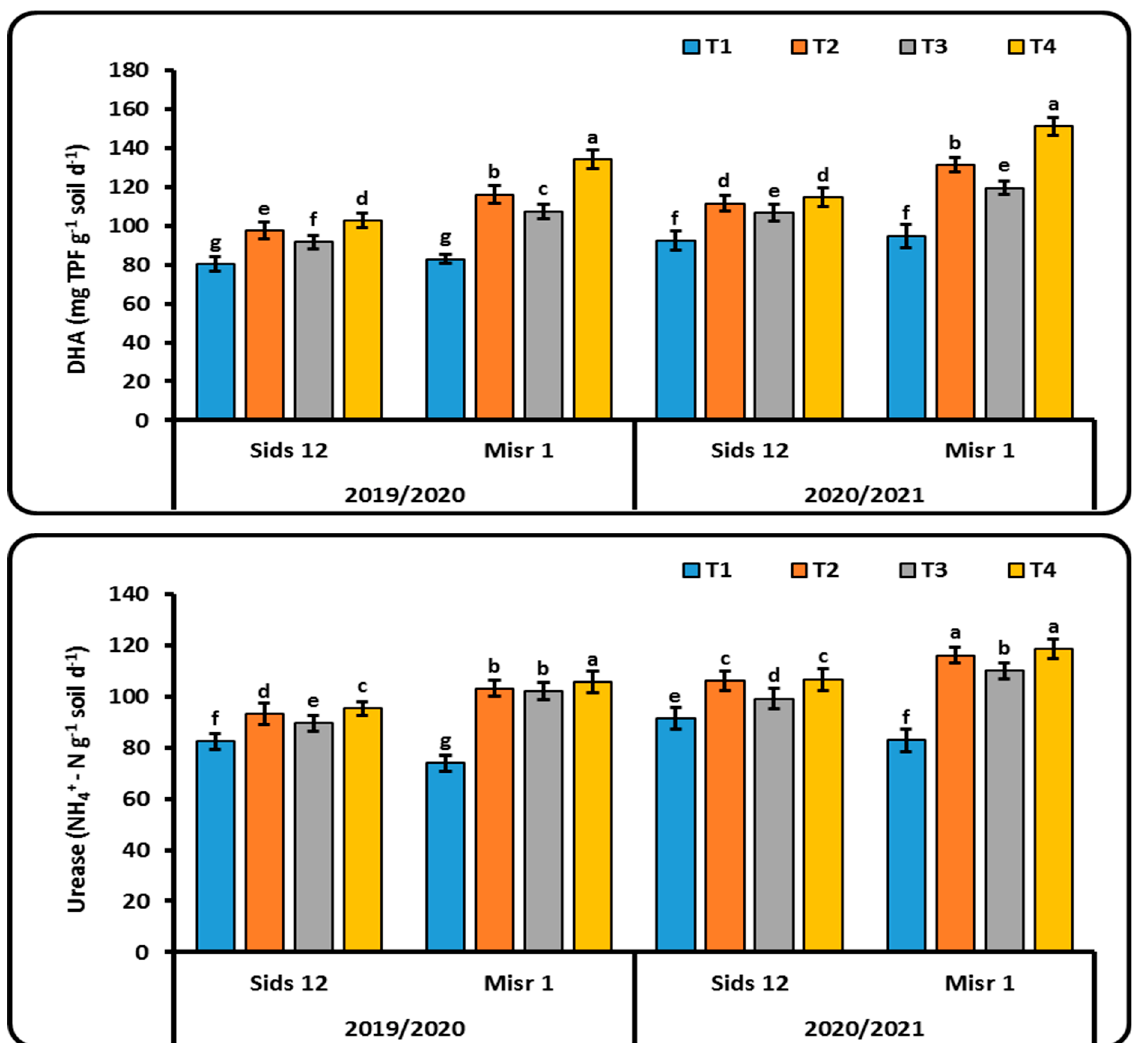
Figure 2. Impact of different treatments (EM, CT, and combination) on soil enzyme activities 70 days after sowing, during the two growing seasons. Duncan’s test ( p ≤ 0.05); means for the same growth season denoted with different letters indicate significant differences across treatments. (±) means standard deviations (SD, n = 3). Control (T1); EM (T2); CT (T3); EM + CT (T4).